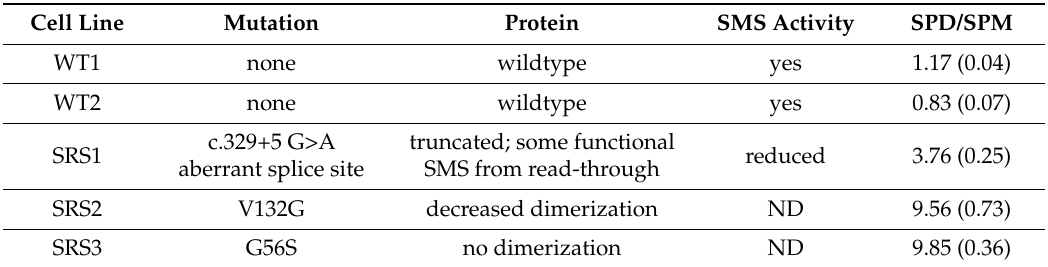
Table 1. Characteristics of lymphoblastoid cell lines. SPD/SPM ratios represent means with (SEM) n = 5. Mutations, protein products, and spermine synthase (SMS) activity were as previously reported [10]. ND = none detected.